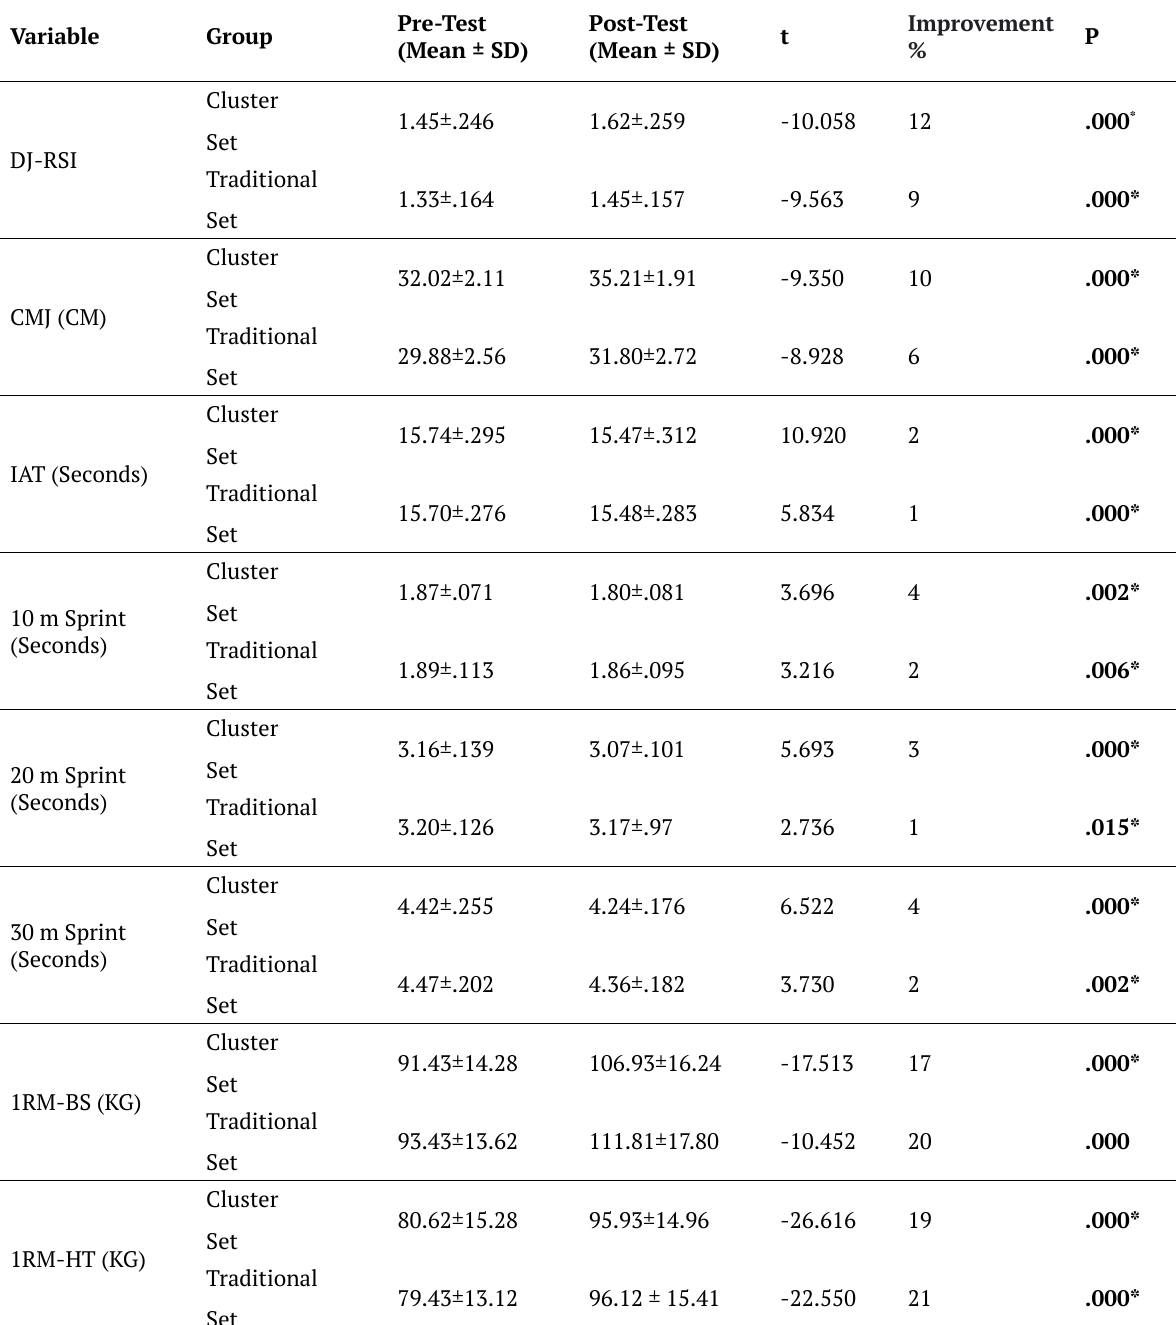
Table 5. T-Test Results Regarding The Difference Between Pre-Test And Post-Test, RSI, CMJ, IAT, Speed And Maximal Strength Values Within